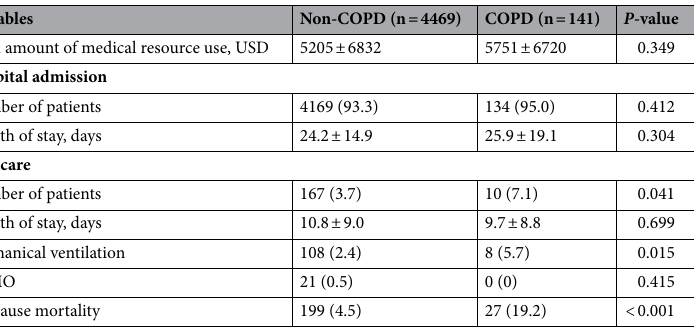
Table 2. Clinical outcomes of COVID-19 in COPD and non-COPD patients. Data are presented as numbers (%) or means ± standard deviations. COVID-19 coronavirus disease 2019, COPD chronic obstructive pulmonary disease, USD United States dollar, ICU intensive care unit, ECMO extracorporeal membrane oxygenation.